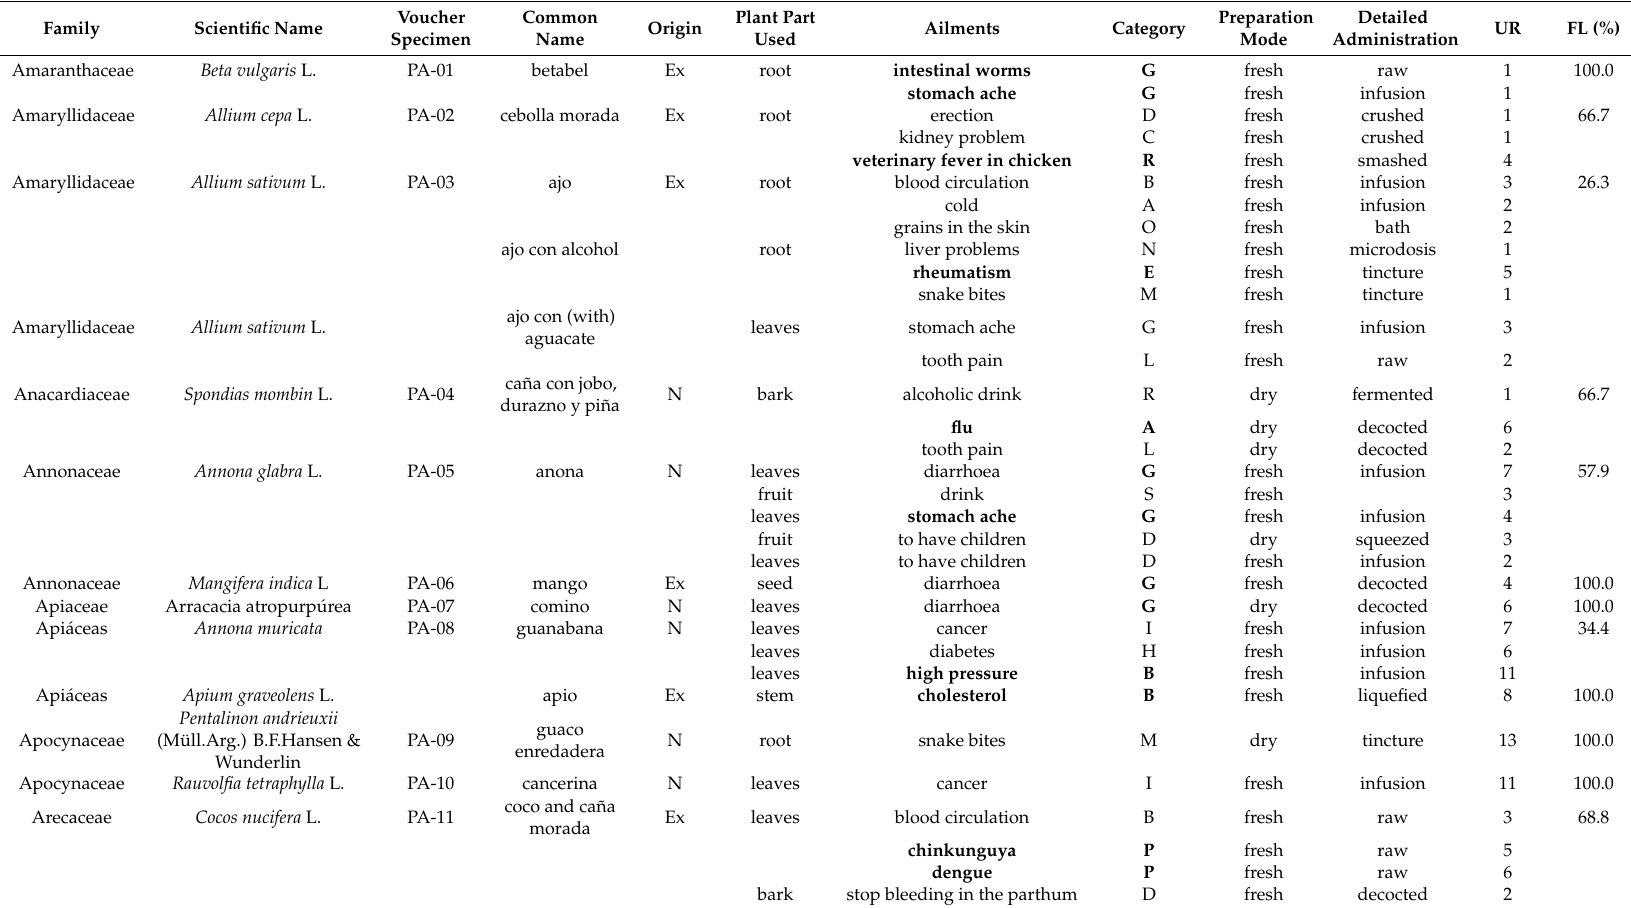
Table 2. Traditional use of medicinal plants among herbal practitioners in the study area (Totonac indigenous group).